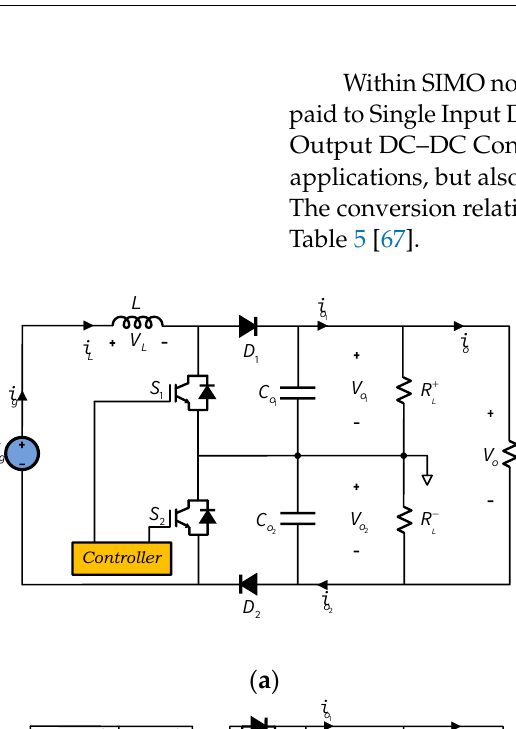
Figure 7. Single Input Multiple-Output (SIMO) non-isolated multiple switches DC – DC converters. ( a ) SIMO Buck Converter versions [57]. ( b ) SIMO Boost Converter versions. ( c ) SIMO Buck – Boost Converter versions.